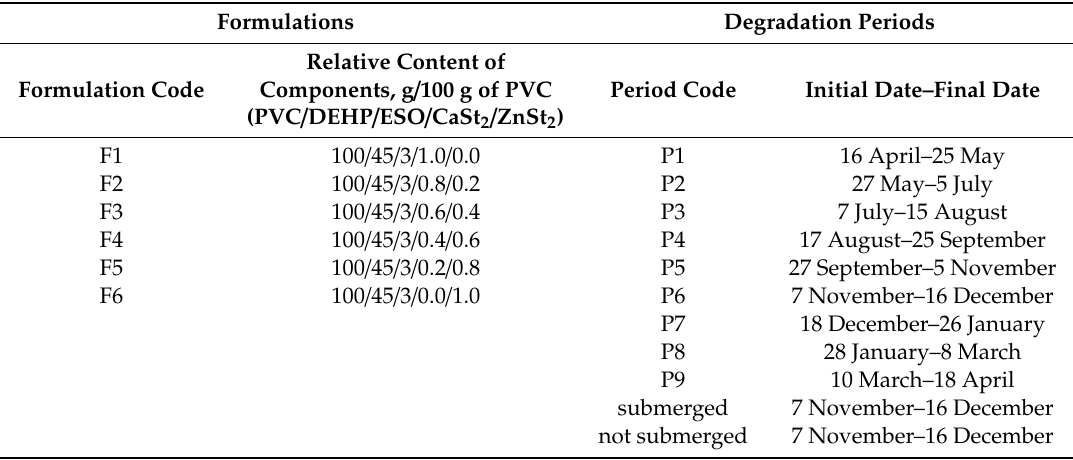
Table 3. Description of the tested formulations and the considered degradation periods.